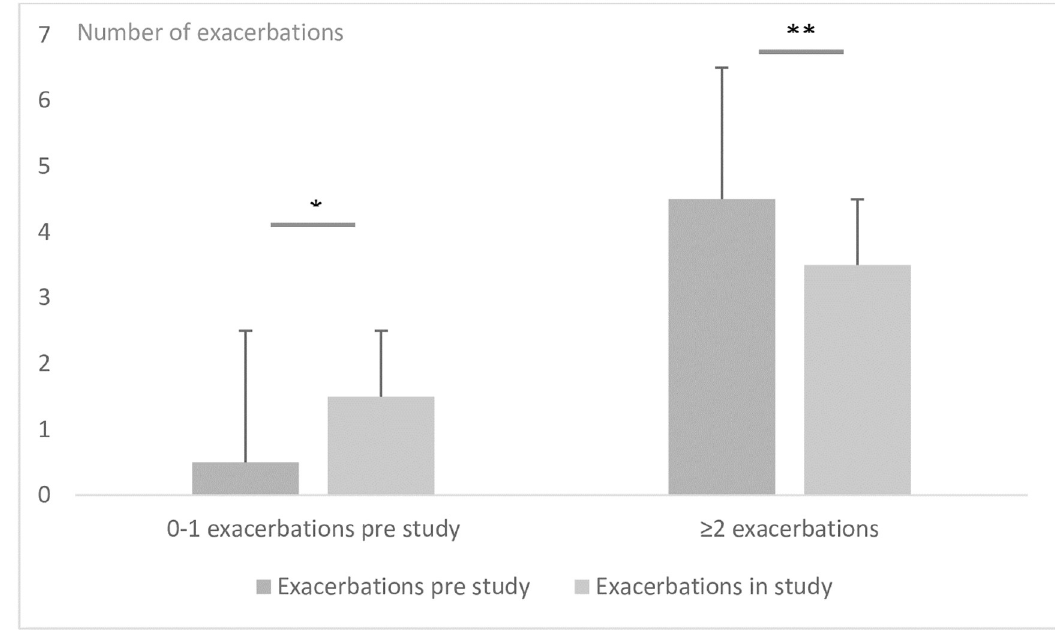
Fig 2. Number of exacerbations 12 months prior to study inclusion and during 12 months’ study participation in subgroups with 0–1 and 2+exacerbations in the year prior to inclusion. � p = 0.01 �� p =